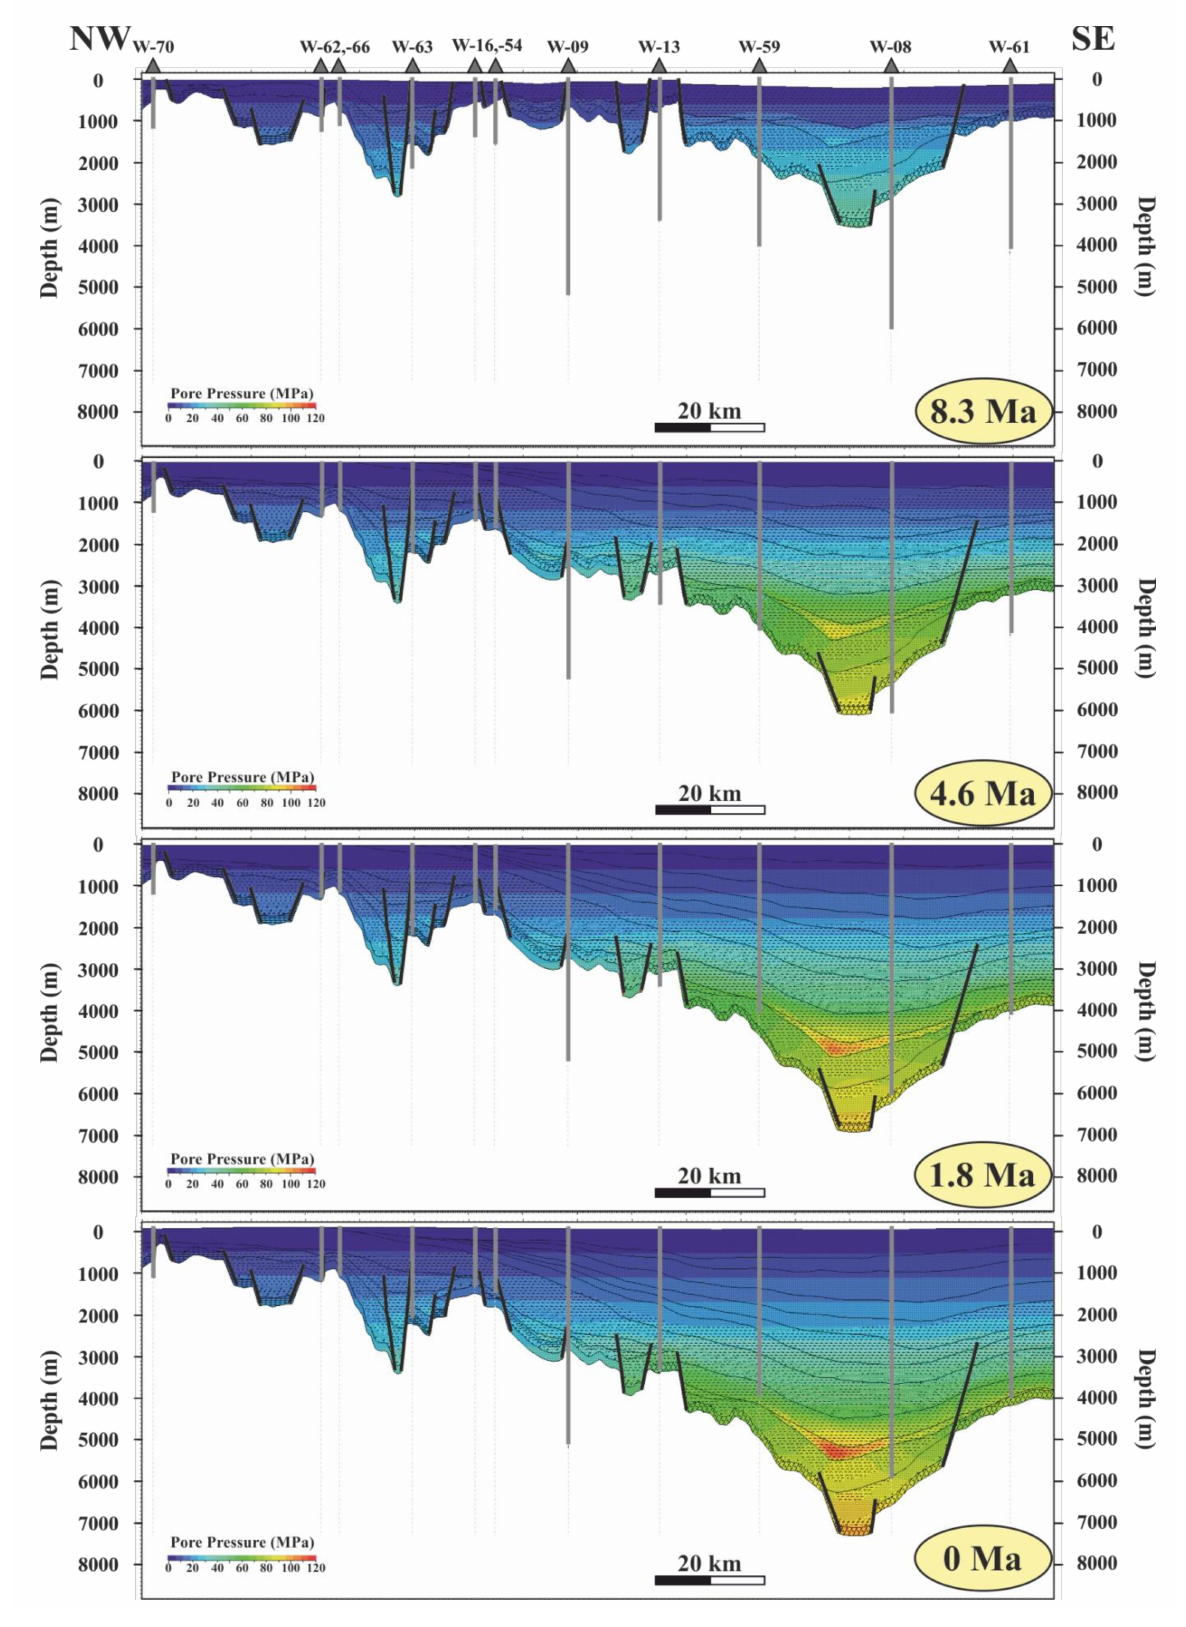
Figure 11. Development of the subsurface pore pressure system during the last 8.3 Ma. According to the simulation, the most significant pressure anomaly could form in the deepest part of the